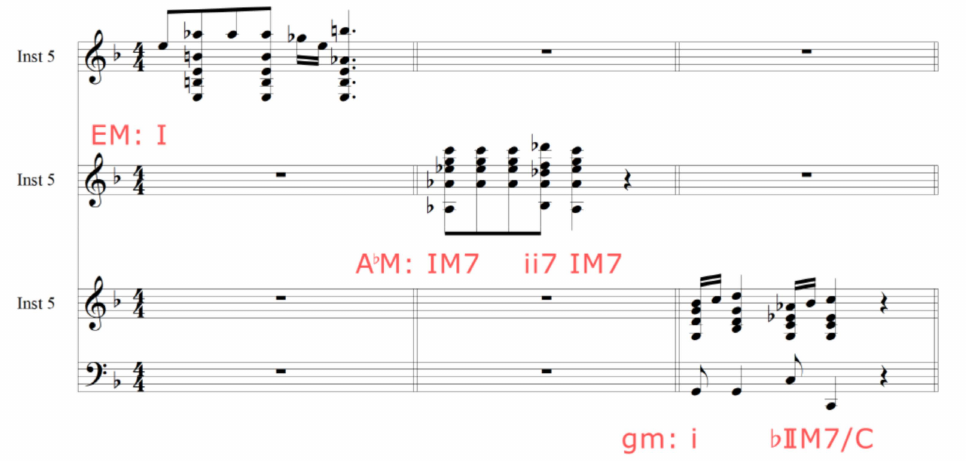
Figure 3. Original track scores for sound coding saturated (left), light (middle), and dark (right) colors from Vivaldi’s The Four Seasons.